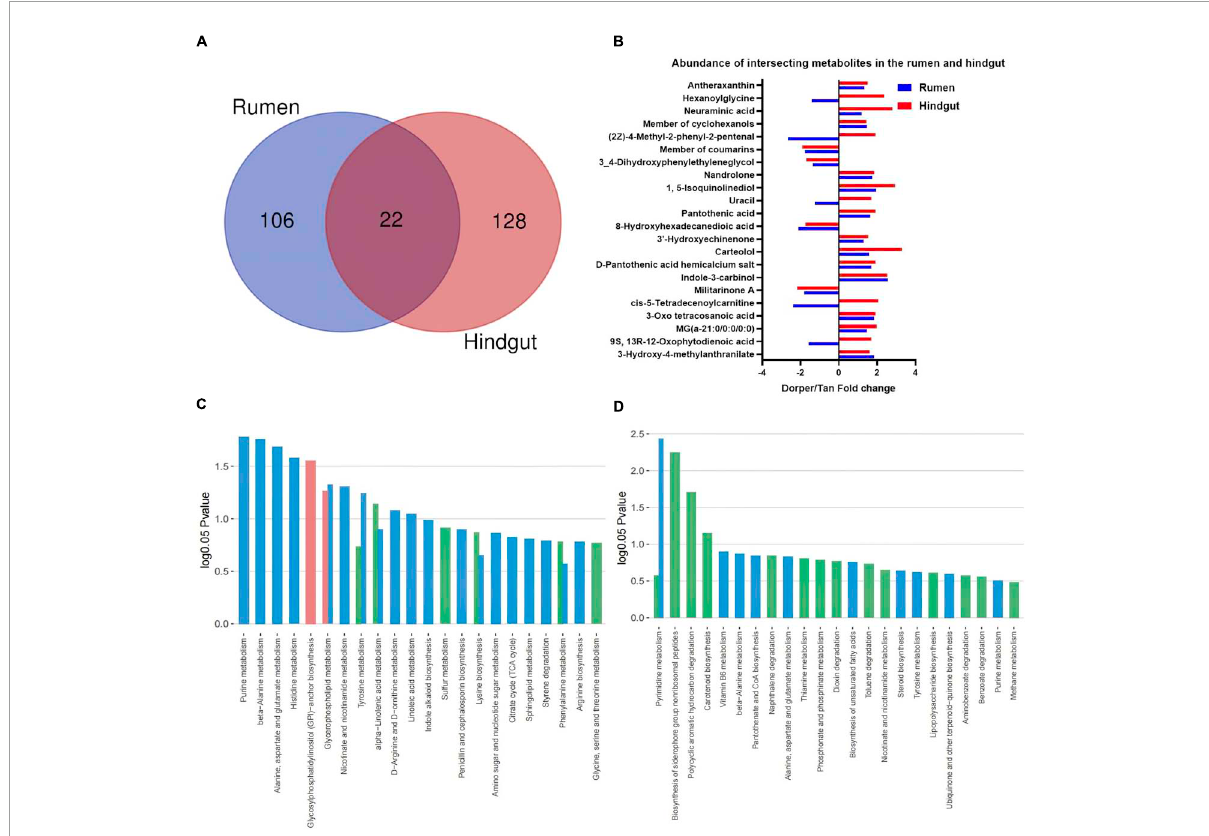
FIGURE6 Functional analysis of the metabolome (A) Venn analysis of significantly different metabolites in rumen and hindgut. (B) Visualization of key metabolites in the rumen and hindgut. Dorper/Tan foldchange is +. (C,D) KEGG enrichment analysis of rumen and hindgut differential metabolites. Venn diagram represents the statistics of enriched metabolic pathways in